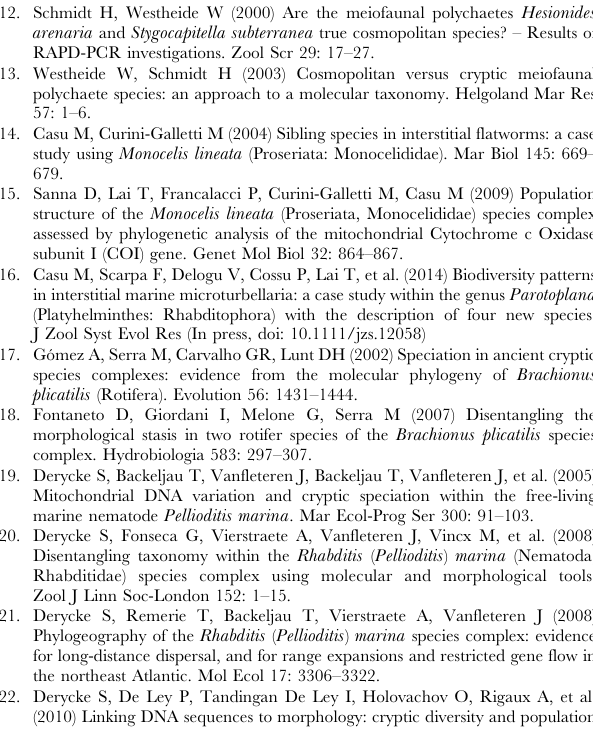
Table S1 Morphotype, cryptic species (number with prefix E.), Locality, GenBank accession number, and relative bibliographic reference are indicated for each COI sequence of Cephalothrix spp., Ototyphlonemertes spp., and Tetrastemma spp. used in the present work. Specimens are ordered by